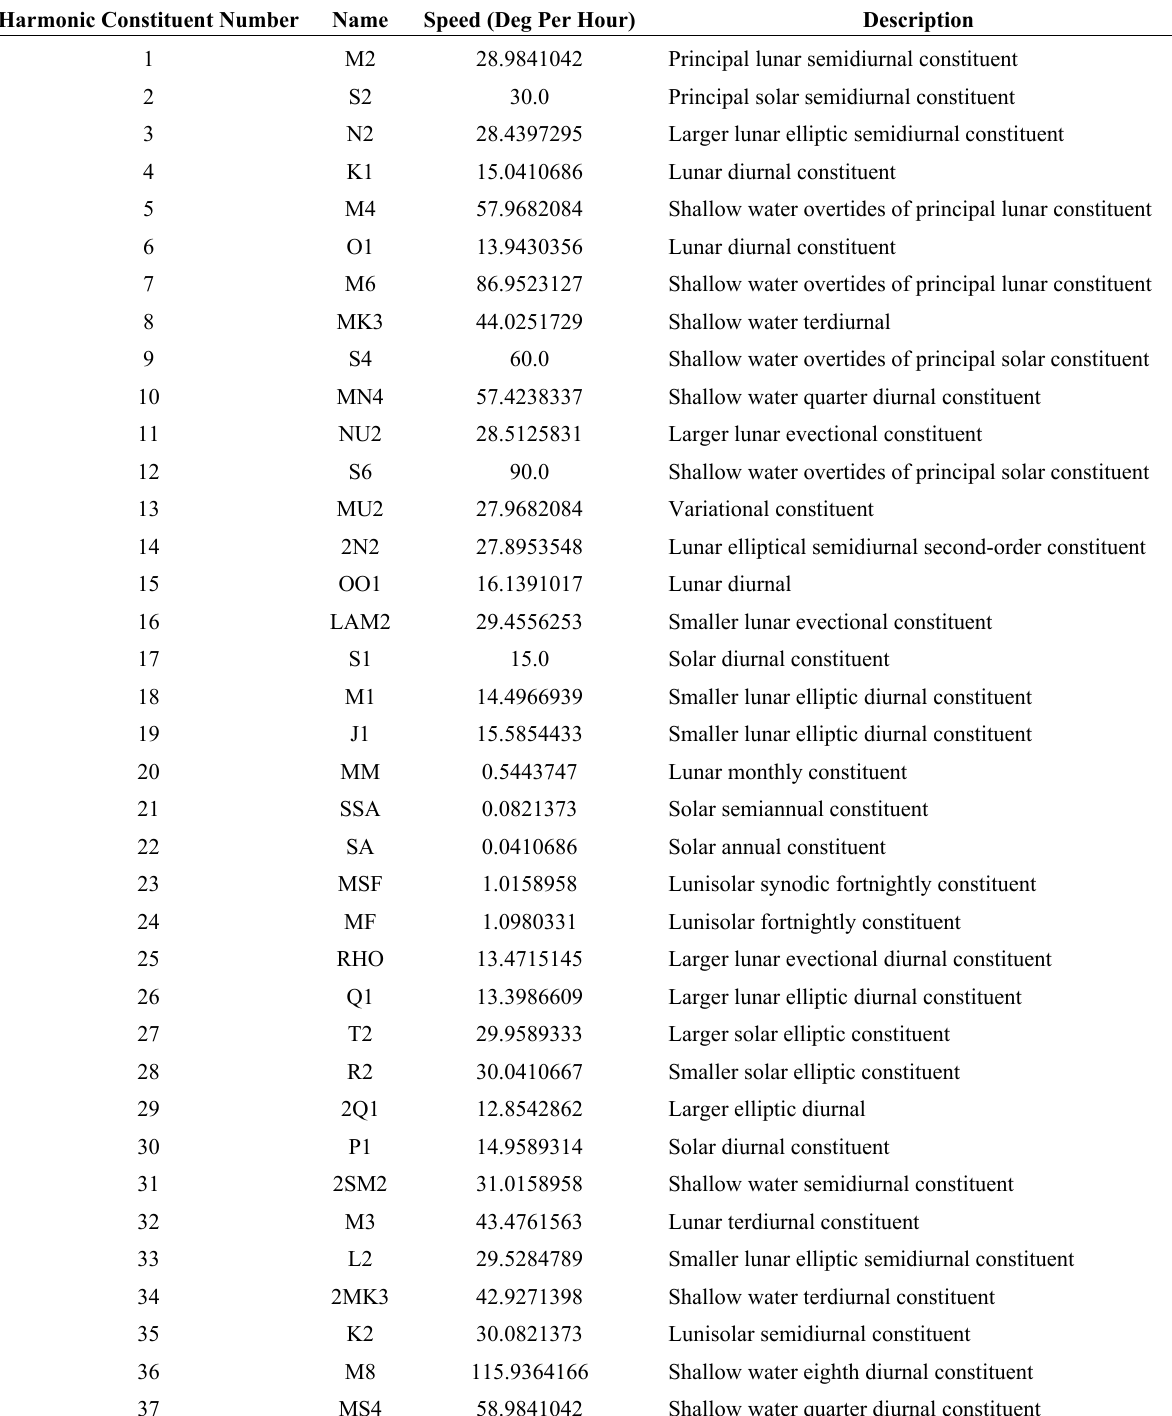
Table 2. Harmonic tidal constituents used in SLOSH. Each constituent represents a periodic variation in the relative positions of the earth, moon and